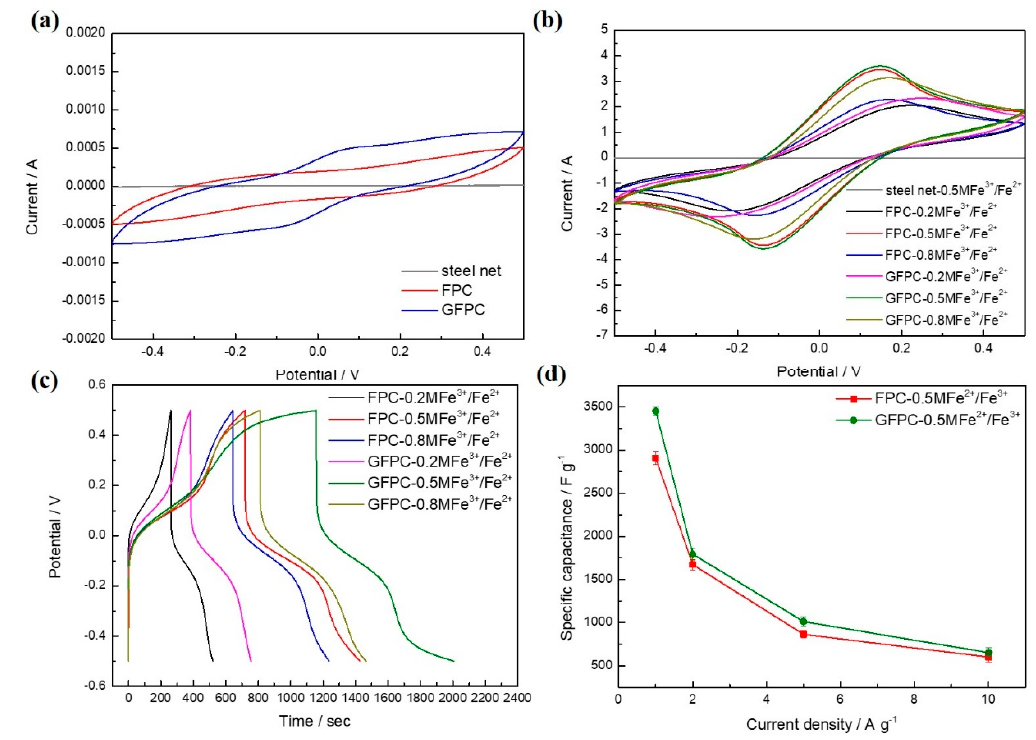
Figure 6. ( a ) The cyclic voltammetry (CV) curves of the FPC and GFPC in 1 M H 2 SO 4 at a scan rate of 5 mV ∙ s − 1 , ( b ) the CV curves of the FPC and GFPC in 1 M H 2 SO 4 + 0.2/0.5/0.8 M Fe 3+ /Fe 2+ electrolytes at a scan rate of 5 mV ∙ s − 1 , ( c ) the galvanostatic charge–discharge (GCD) curves of the FPC and GFPC in 1 M H 2 SO 4 + 0.2/0.5/0.8 M Fe 3+ /Fe 2+ electrolyte of 1 A ∙ g − 1 , ( d ) the specific capacitance of FPC and GFPC with different current densities in a 1 M H 2 SO 4 + 0.5 M Fe 3+ /Fe 2+ electrolyte.